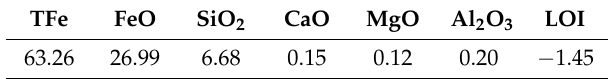
Table 1. Chemical composition of iron ore concentrate (mass%).